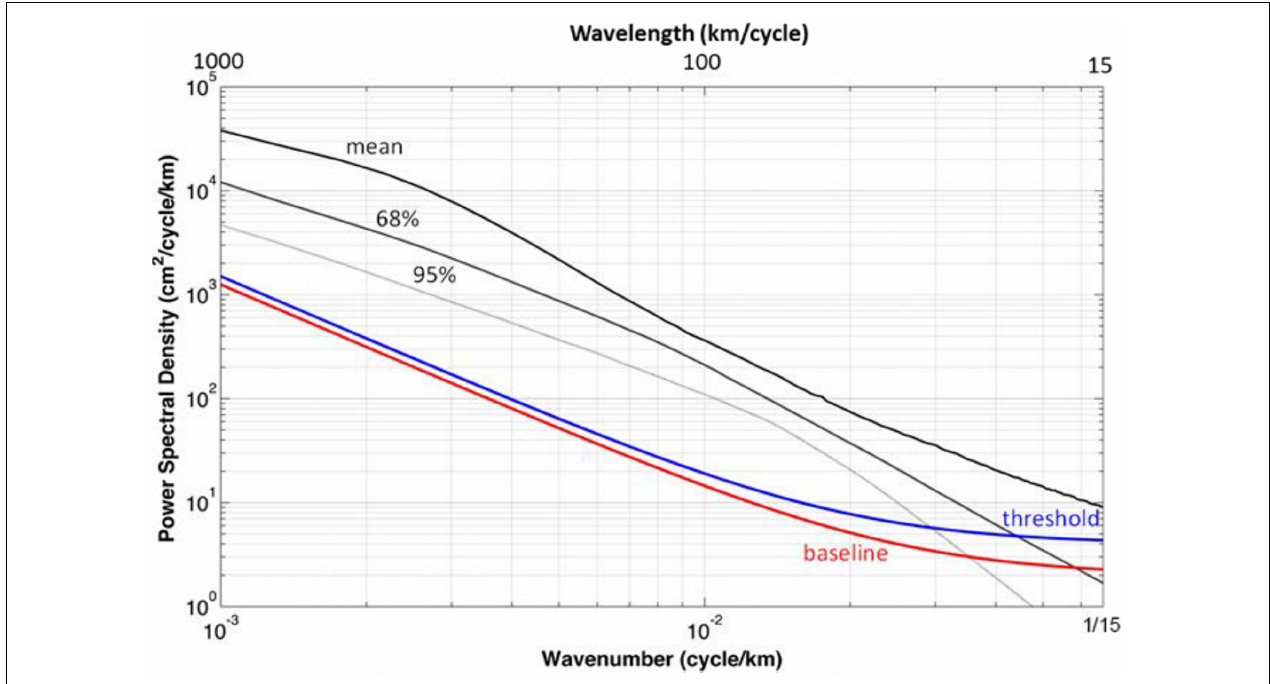
FIGURE 3 | SSH baseline requirement spectrum (red curve) as a function of wavenumber represented by an empirical function, E( k ) = 2 + 0.00125 k - 2 , where k represents along-track wavenumber. The blue curve is the threshold requirement. Shown for reference is the global mean SSH spectrum estimated from the Jason-1 and Jason-2 observations (thick black line), the lower boundary of 68% of the spectral values (the thin black line), and the lower boundary of 95% of the spectral values (the gray line). The blue and red lines represent a swath-average performance, and intersect the baseline spectrum at ∼ 15 km (68%) and ∼ 30 km (95%), respectively (Desai, 2018; Credits: NASA-JPL